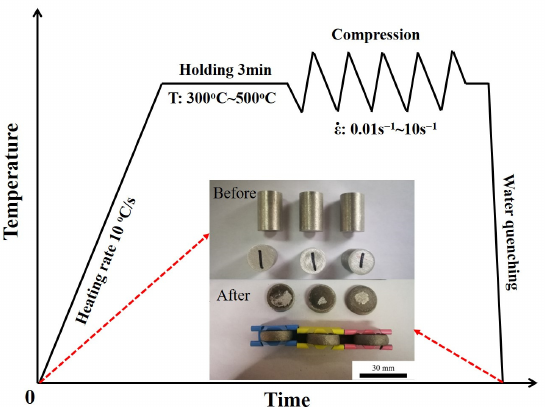
Figure 1. Compression test process and morphology of compressed samples.